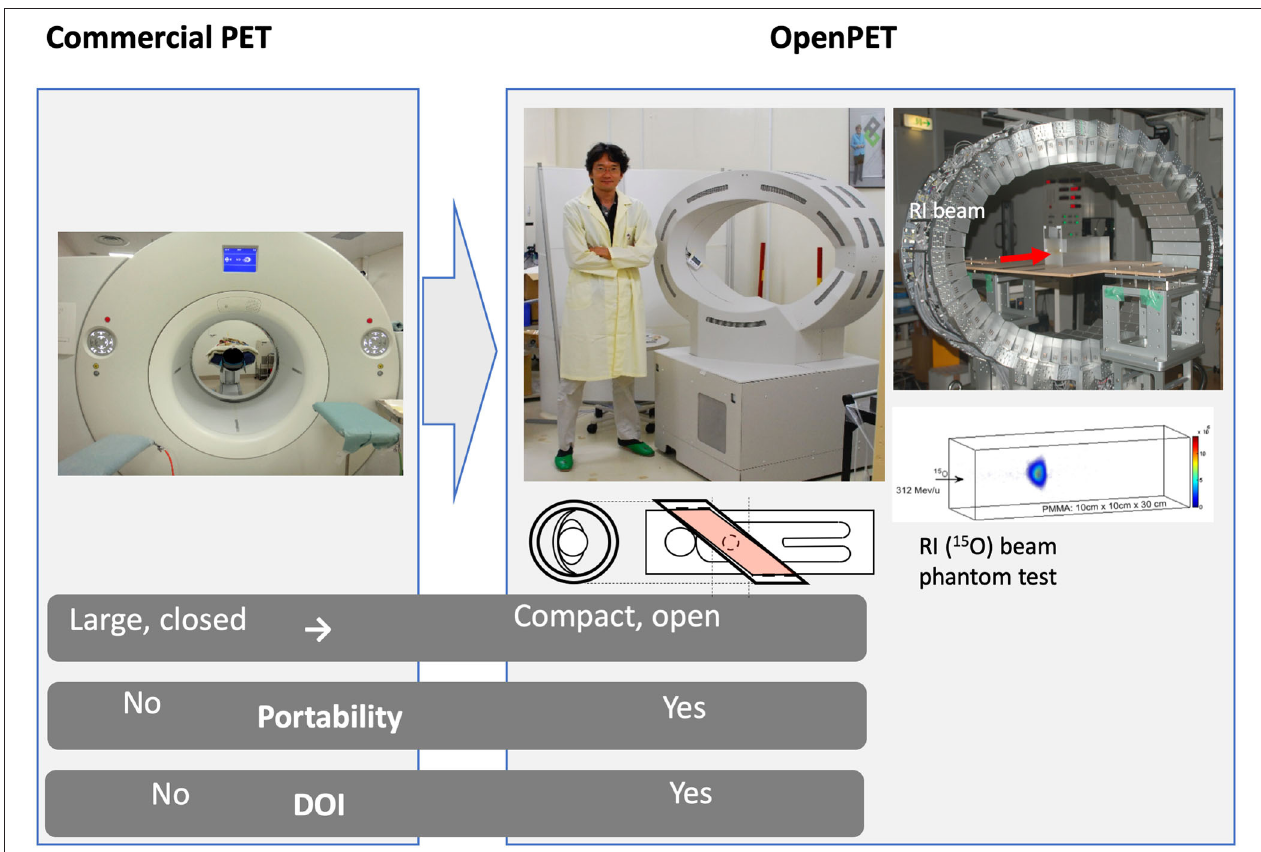
FIGURE 6 | The OpenPET imaging detector developed at NIRS in the Taiga Yamaya laboratory, along with images of a 15 O beam in a plastic target. Image from https://www.nirs.qst.go.jp/usr/medical-imaging/imaging-physics/index-en.html, reproduced with